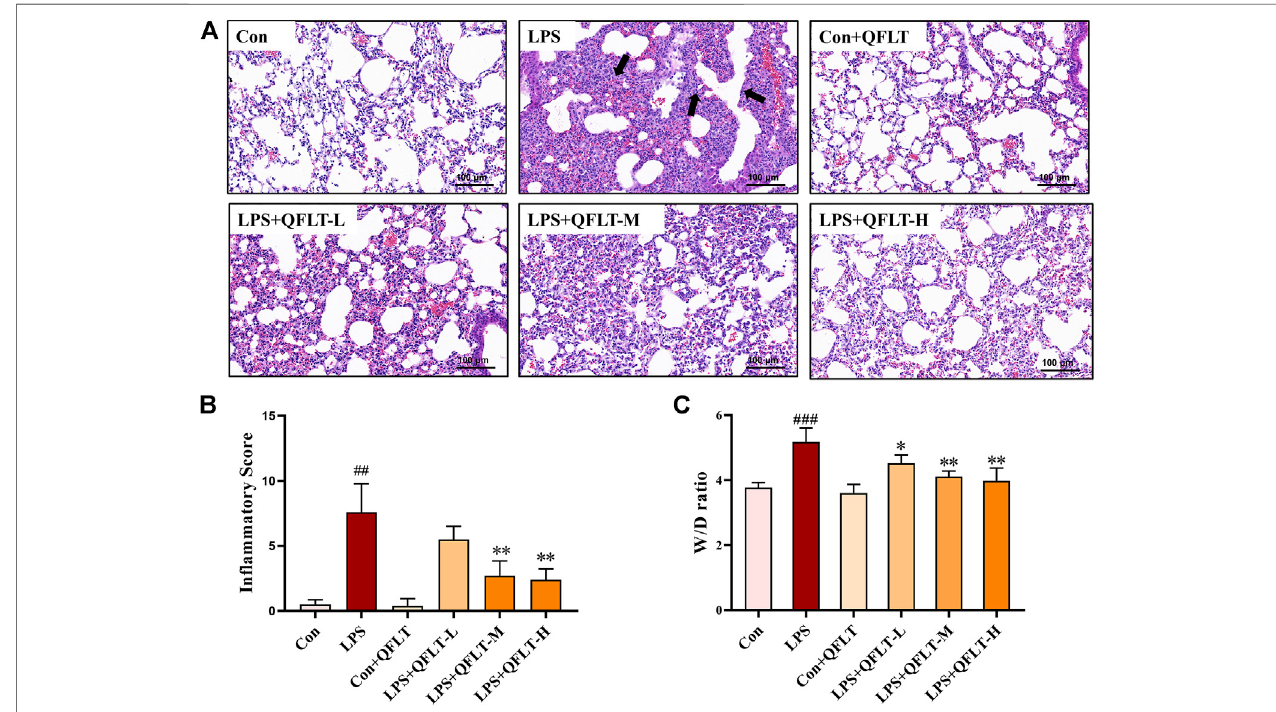
FIGURE 7 | The effect of QFLT treatment against LPS-induced acute lung injury. QFLT (4, 8, and 16 g/kg) was administered to mice once daily for 7 days before intratracheal instillation of LPS (5 mg/kg). 24 h later, all mice were anesthetized and sacri fi ced. (A) Representative histological H&E-stained lung sections (×100). The blackarrowindicatedthealveolar structure wasseverelydamaged,and thealveolarcavityhemorrhageswithin fl ammatorycellin fi ltration. (B) In fl ammatory Score (C) W/ D ratio were determined at 24 h after LPS challenge. The values represented the mean ± SD ( n = 5). ## p < 0.01 vs. the control group; * p < 0.05 vs. the LPS group.